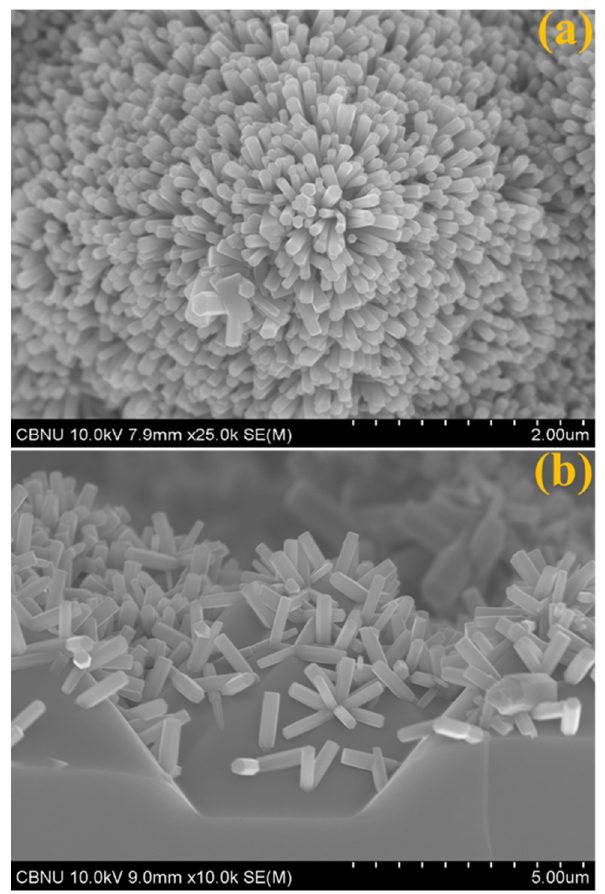
Figure 3. FESEM image of ( a ) top and ( b ) cross-sectional view of ZnO NRs for 5 h.